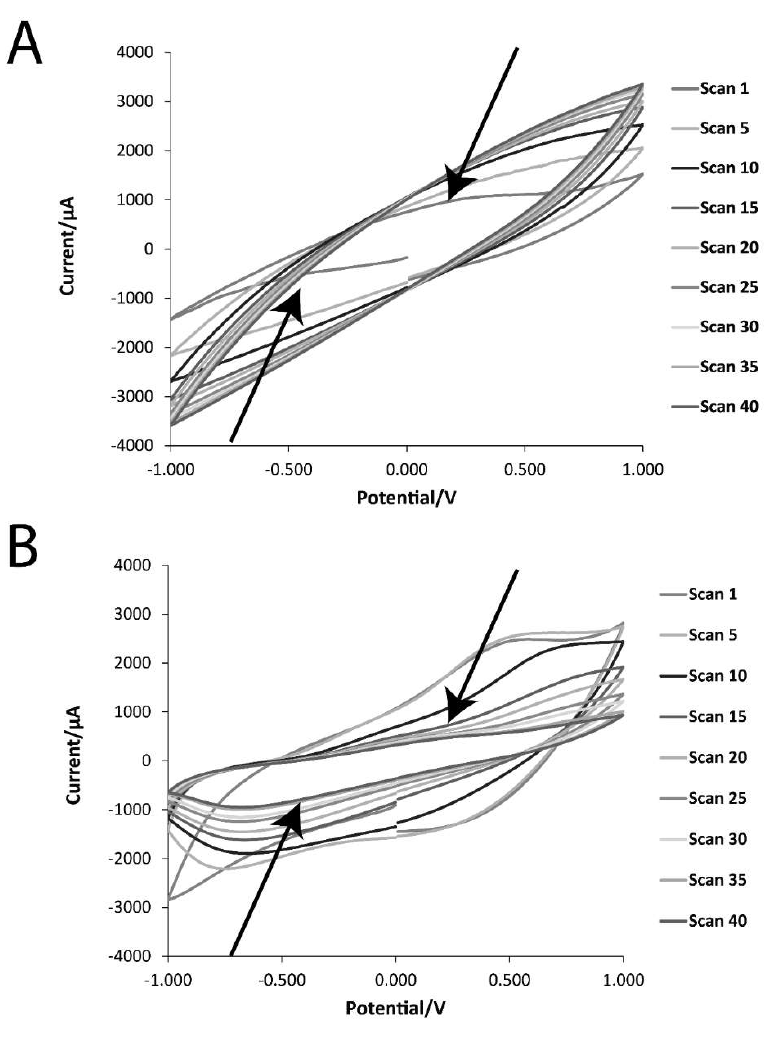
Figure 7. Cyclic voltammetry (CV) data of the films in phosphate-buffered saline (PBS; pH = 7.4) at a scan rate of 50 mV.s −1 : ( A ) DMP-doped PPY film; ( B ) MER-doped PPY film.